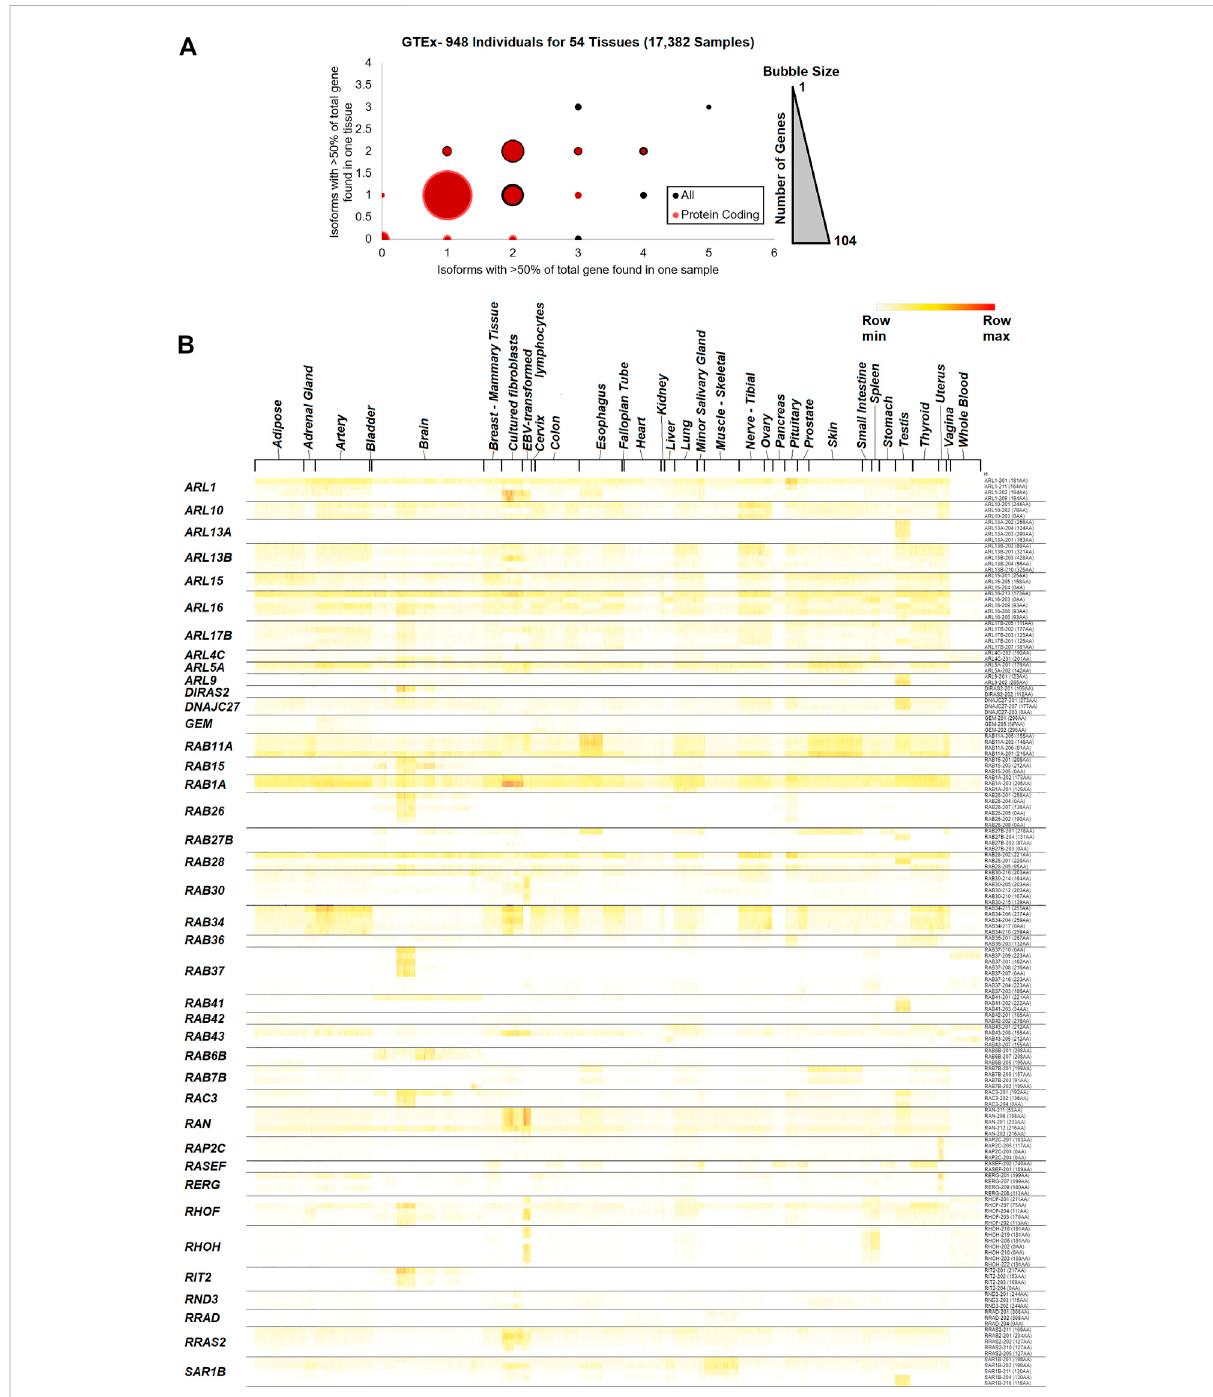
FIGURE 3 GTEx tissue-speci fi c data for small GTPase isoforms. (A) The number of isoforms across samples and tissues. The x -axis shows the number of isoforms that account for at least 50% of the gene expressionin one sample, while the y -axis shows the number of isoforms that account for at least 50% of the gene expression in one tissue. The bubble size represents the number of isoforms at each x and y level, with a maximum of 104. The red spots represent protein-coding transcripts, and the black spots all transcripts. (B) Heat map of transcript expression for several small GTPase genes with more than one isoform expressed across tissues. Sample tissues are labeledon thetop and isoformsfor each gene on theright. Coloring is based on the z-score for each gene, with the middle level in yellow and the highest in red.